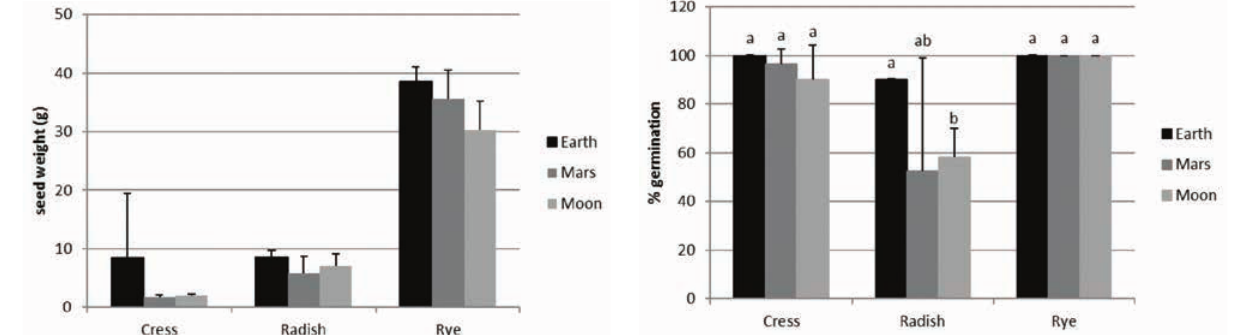
Figure 2: Total aboveground combined dry biomass production for ten different crops, garden cress, rocket, tomato, radish, rye, quinoa, Figure 3: Seed weight of cress, radish and rye harvested from plants spinach, chives, pea and leek on Mars and Moon soil simulant and grown on Mars and Moon soil simulants and Earth potting soil. Earth organic soil (control). Different letters indicate significant None of the differences are statistically significant (n=3, p=0.05, for cress due to the large uncertainty in the Earth control)